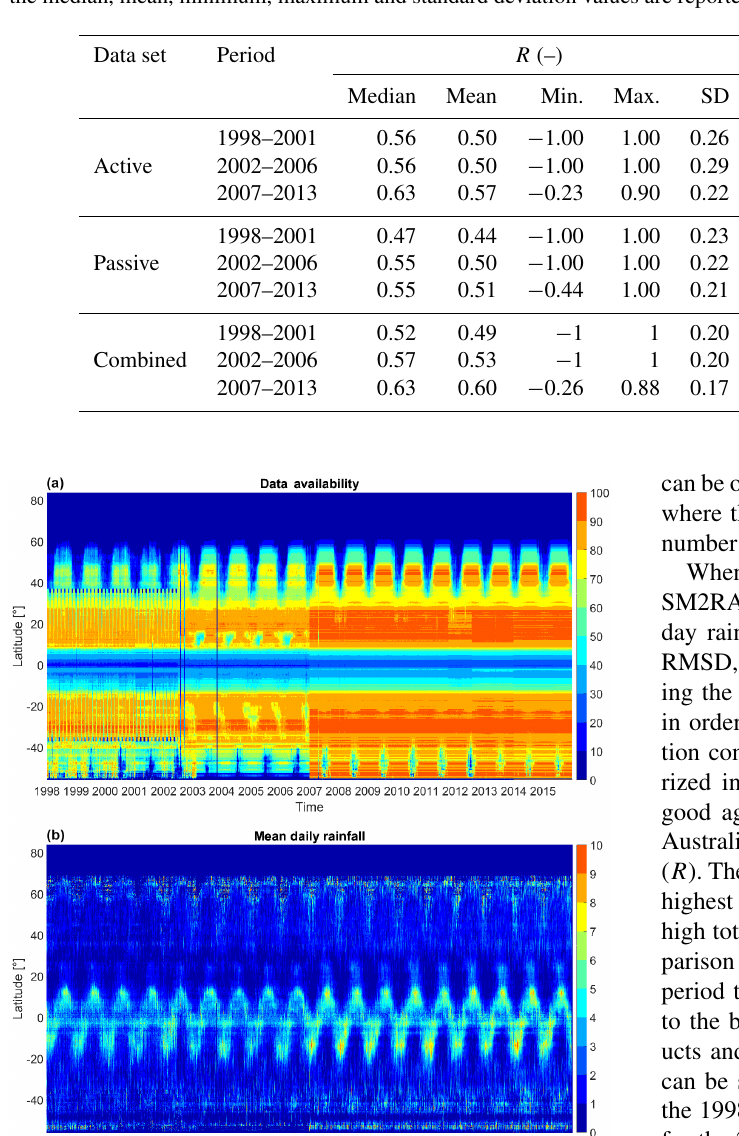
Table 2. Statistical summary of correlation coefficient ( R ) and root mean square difference (RMSD) for ACTIVE, PASSIVE and COM- BINED rainfall data sets against GPCC-FDD during the three calibration periods 1998–2001, 2002–2006 and 2007–2013. For each score, the median, mean, minimum, maximum and standard deviation values are reported.